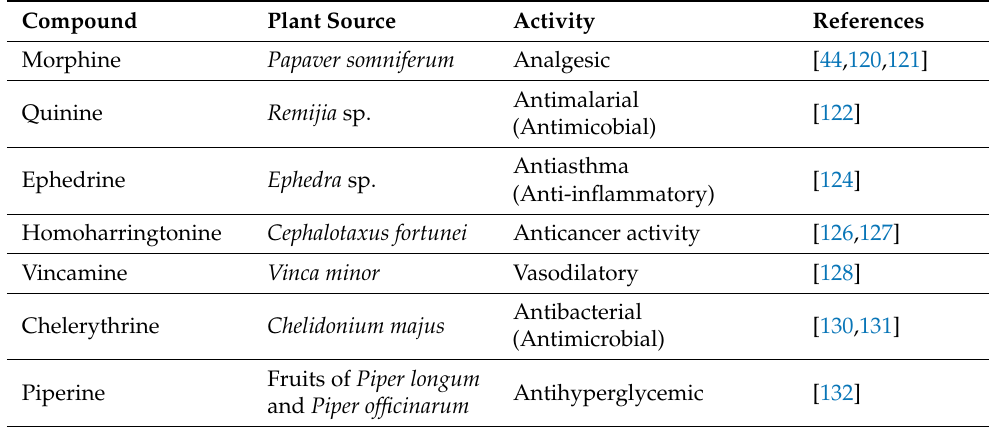
Table 3. Some common plant